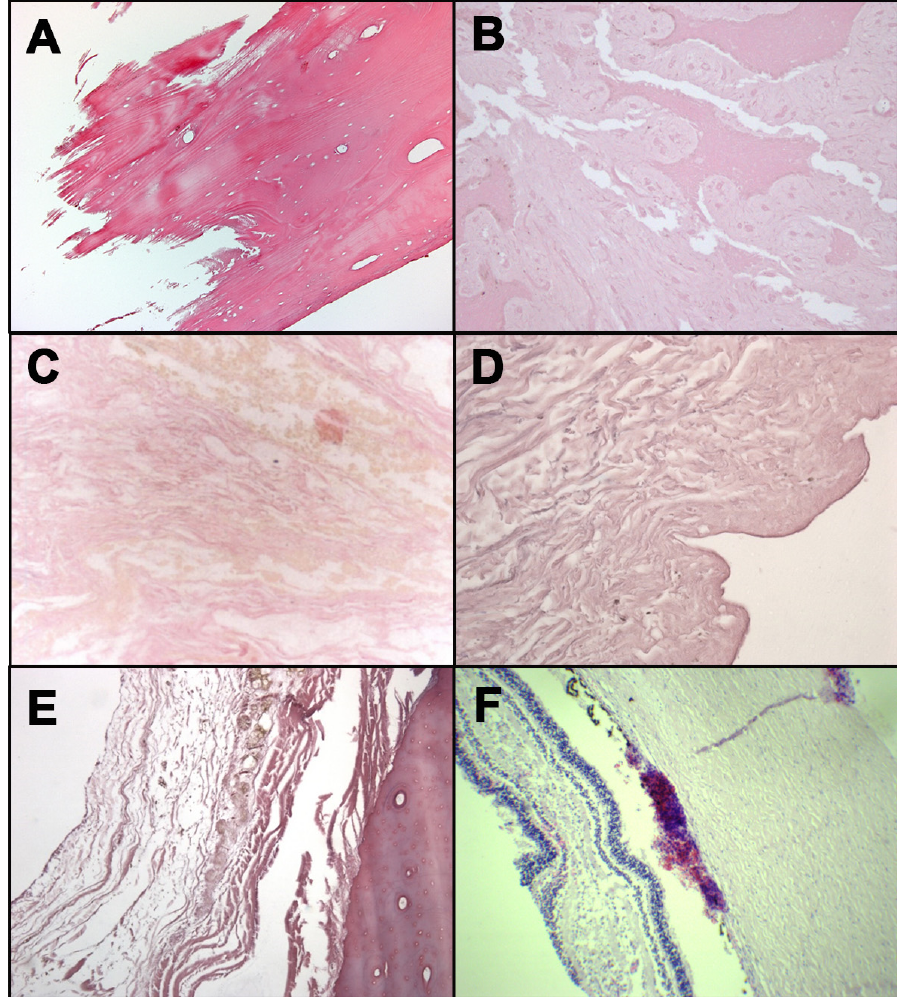
Figure 1. H&E staining: occipital bone from case 1 ( A ); mandible fragment from case 3 ( B ); soft tissues surrounding laryngeal fracture from case 4 ( C ); neck skin from case 5 ( D ); rib fracture from case 5 ( E ); retina from case 6 ( F ).